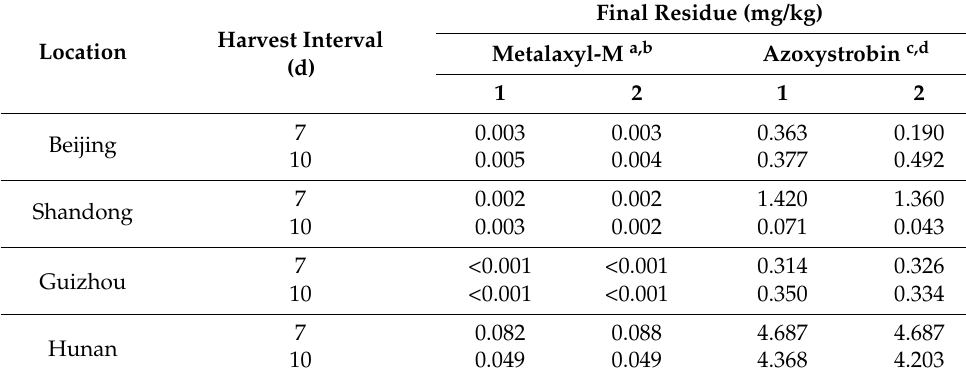
Table 1. Final residues of metalaxyl-M and azoxystrobin in scallion